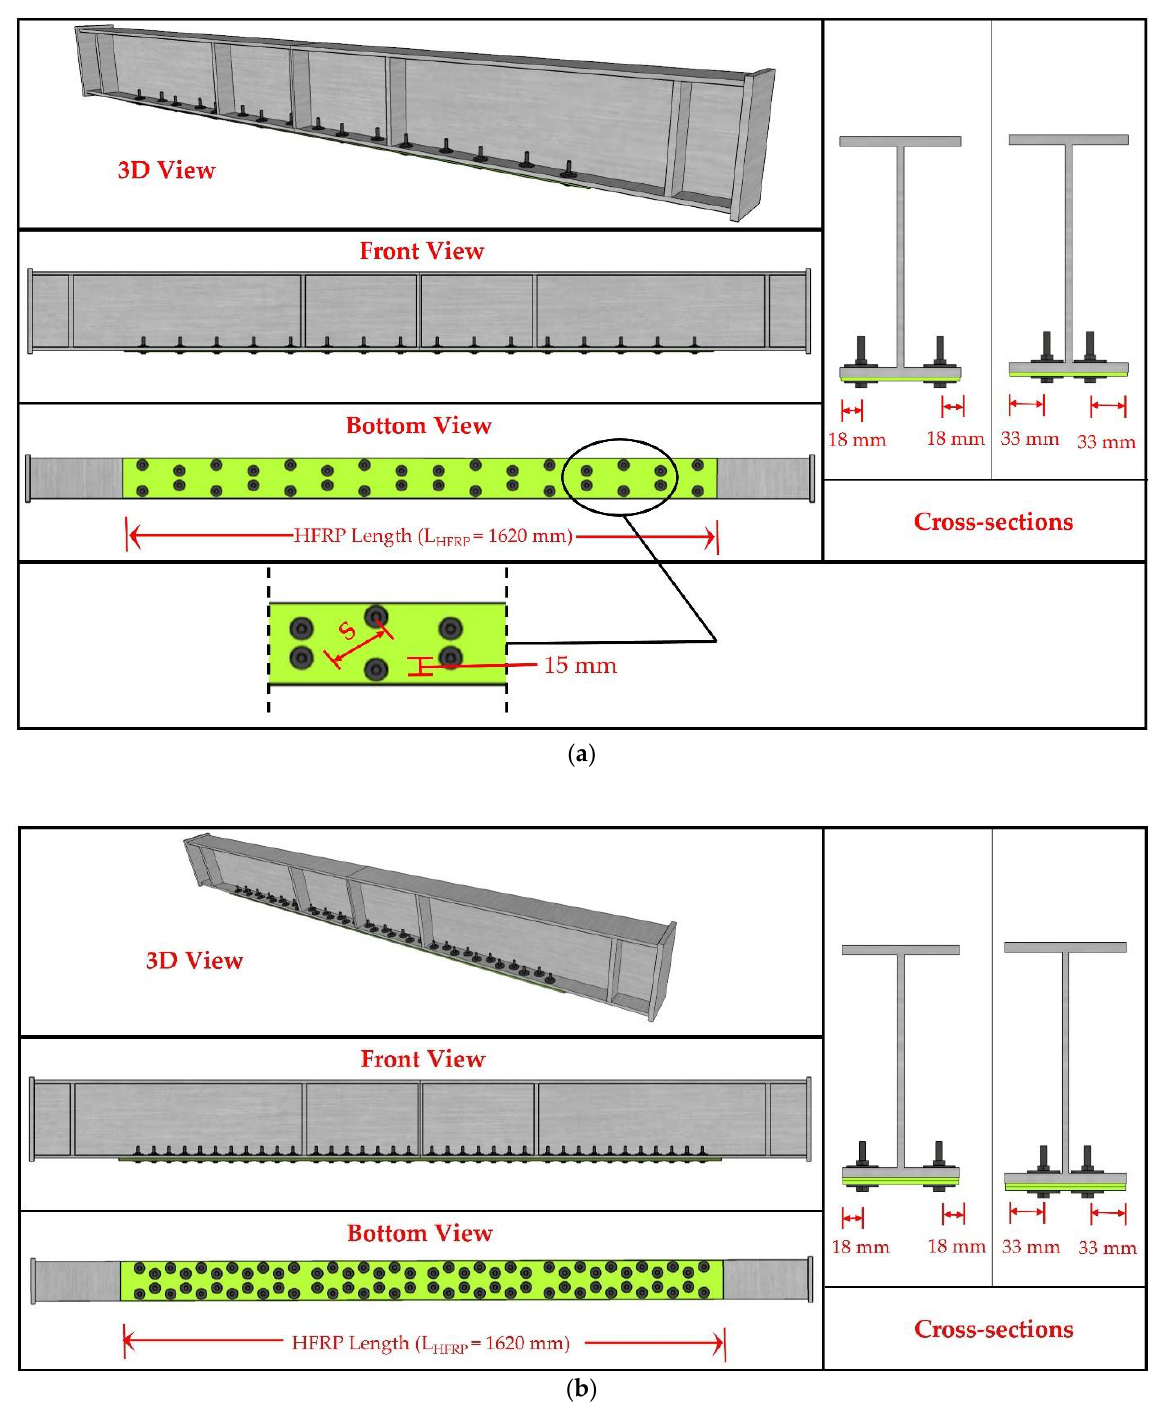
Figure 5. Schematic views of: ( a ) 1620-S-100 beam; ( b ) 1620-D-45 beam.